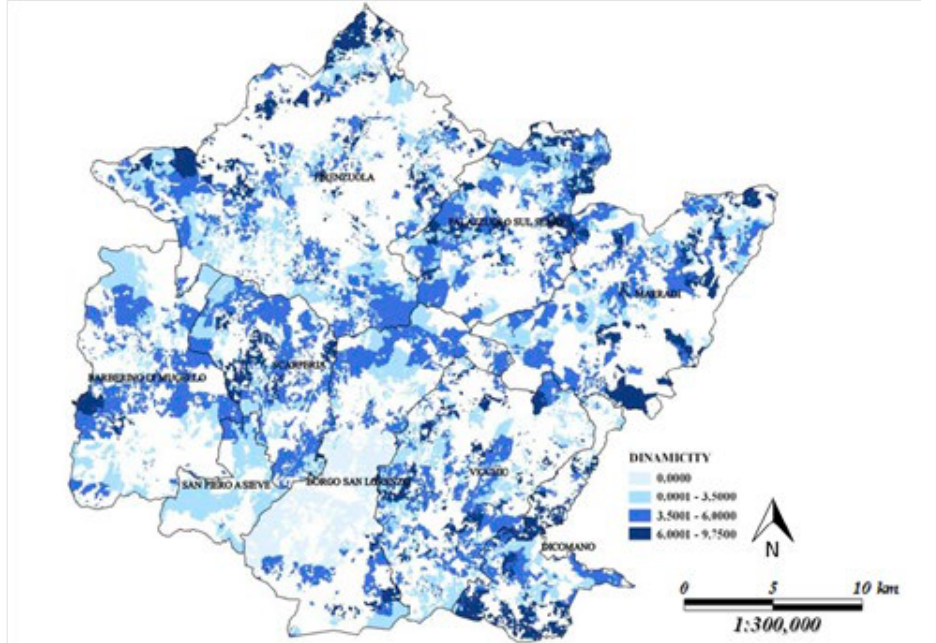
Figure 6. Map of entrepreneurial dynamism in